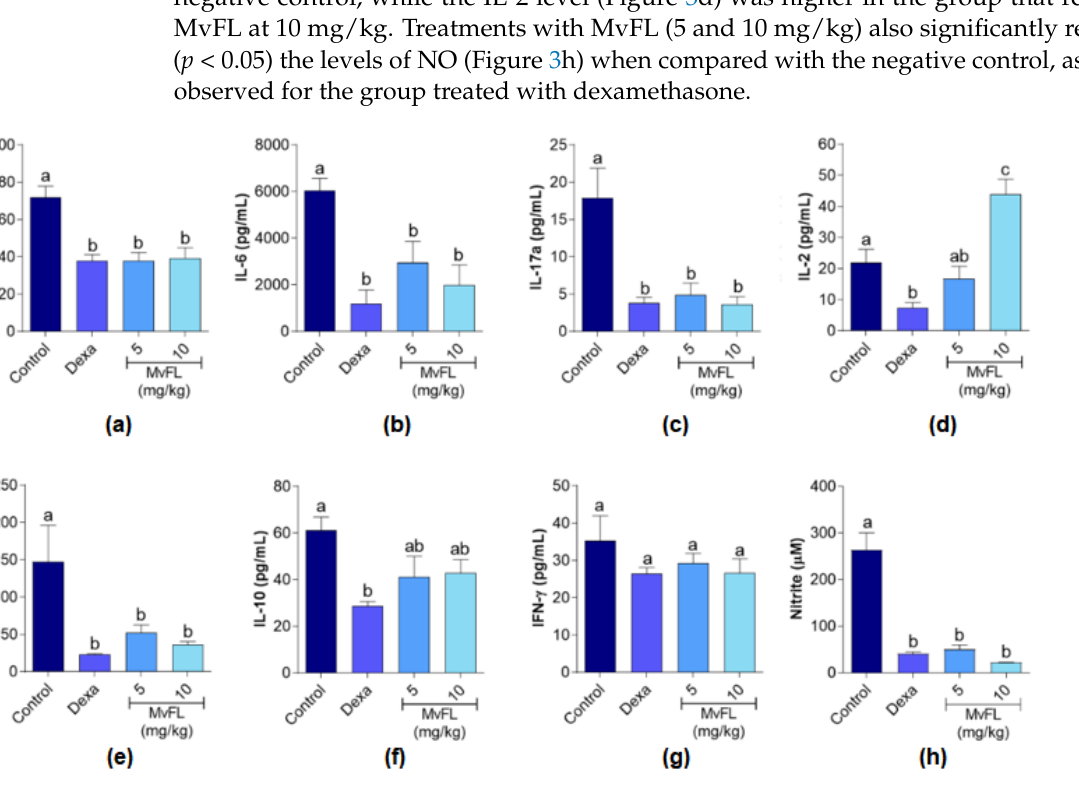
Figure 3. Cytokine ( a – g ) and nitrite ( h ) concentrations in the peritoneal fluid of mice submitted to carrageenan-induced peritonitis after pre-treatment with MvFL (5 and 10 mg/kg) or dexamethasone (2 mg/kg). Values are expressed as mean ± standard error of the mean ( n = 6). Different letters above the bars indicate significant ( p < 0.05) differences between treatments according to ANOVA followed by Tukey’s test.